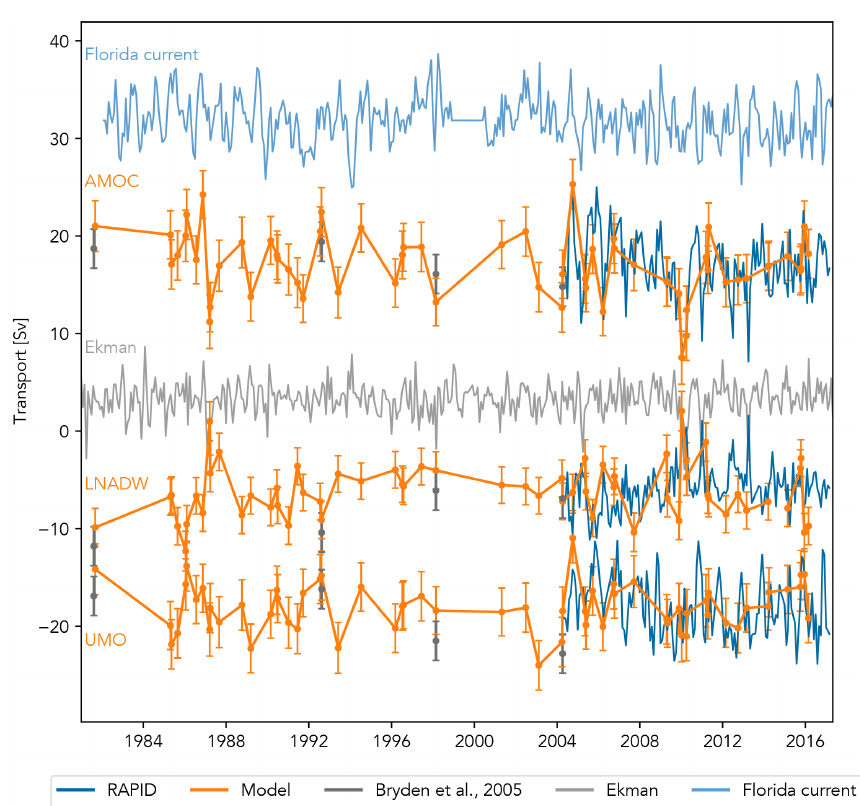
Figure 8. UMO and LNADW transports estimated by empirical models using density anomalies from hydrographic CTD profiles, compared to estimates from RAPID and Bryden et al. (2005). The 980dbar eastern boundary density anomaly for the UMO model was replaced by RAPID monthly climatology. The monthly mean Florida Current and Ekman transports are also shown and were added to the UMO model-estimated transports to give the estimated AMOC